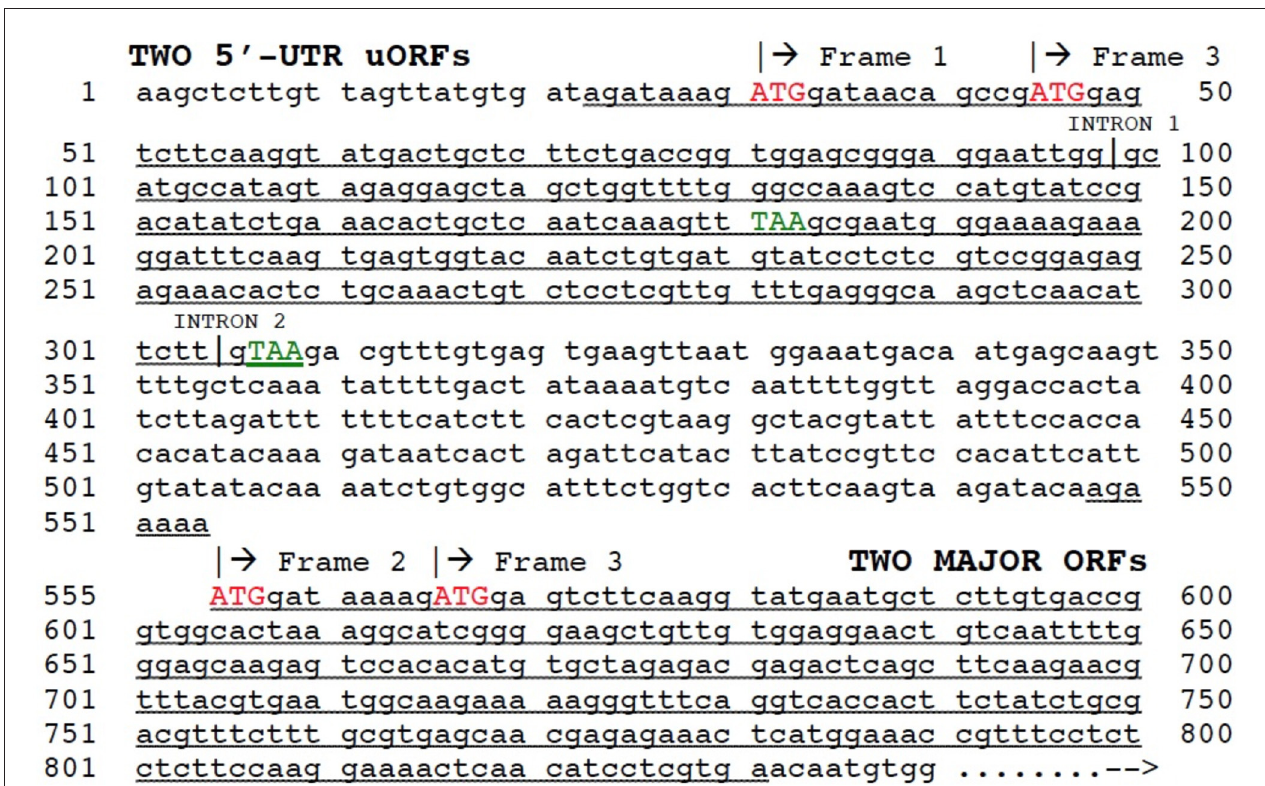
FIGURE 6 | Structure of AT2G29290 (gene 9) mRNA transcript NM_001124936. Regions of duplication (underlined) between 5 ′ -UTR containing two uORFs and 5 ′ -end of major ORF are indicated. Start codons (ATG) are shown in red, and 5 ′ -UTR stop codons (TAA) in green. Positions of the first two introns are marked, although others occur further downstream and are not shown. Reading frames shown by translation analysis are